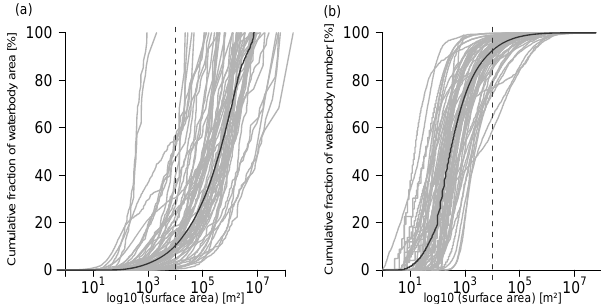
Figure 2. Empirical cumulative distribution function of waterbody area (a) and waterbody number (b) . Grey lines represent individual sites across all regions. Black lines represent the mean function av- eraged over all sites. Vertical dashed line in each panel represents the pond–lake size threshold used in this